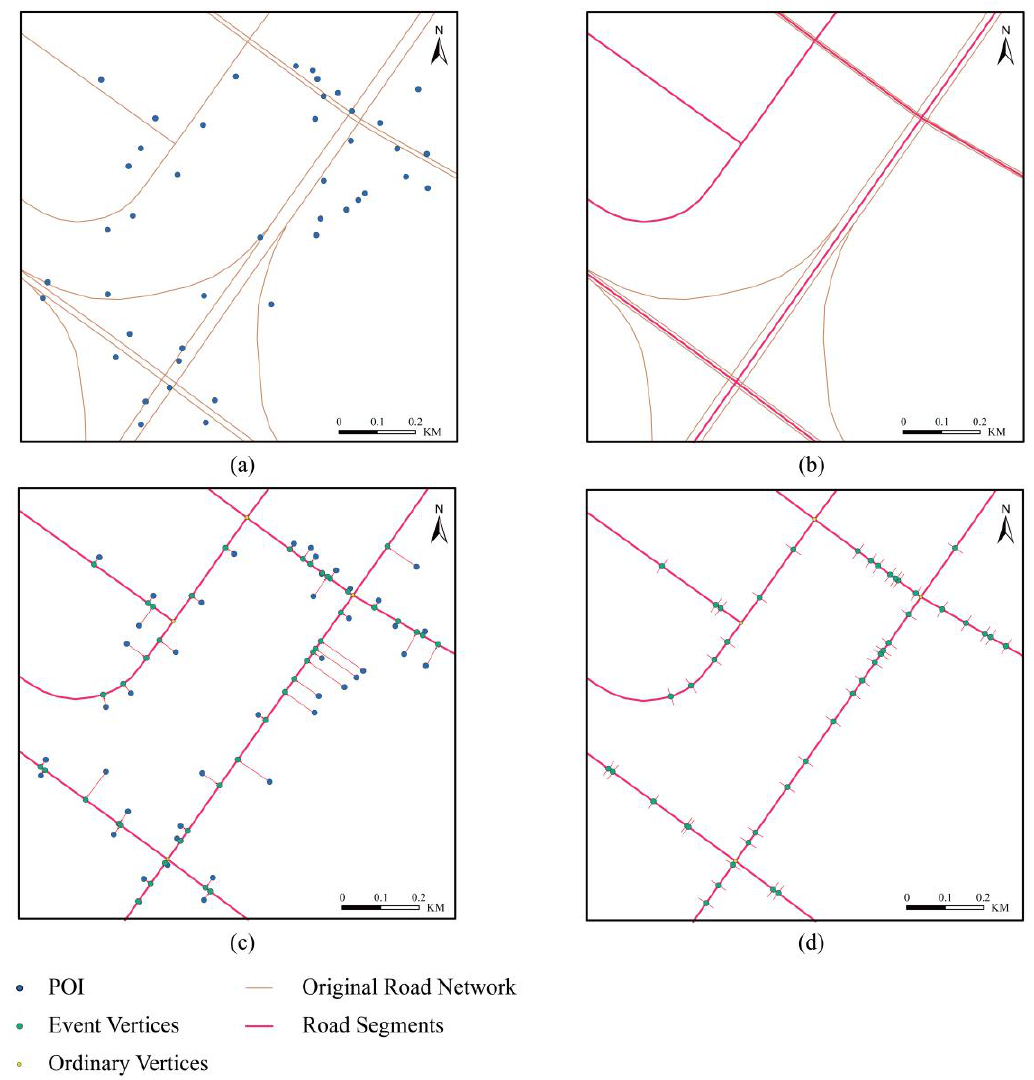
Figure 8. Steps of preprocessing: (a) original dataset; (b) extraction of skeletons; (c) movement of POI to the nearest road segment; and ( d ) splitting of road segments at event to the nearest road segment; and (d) splitting of road segments at event vertices.